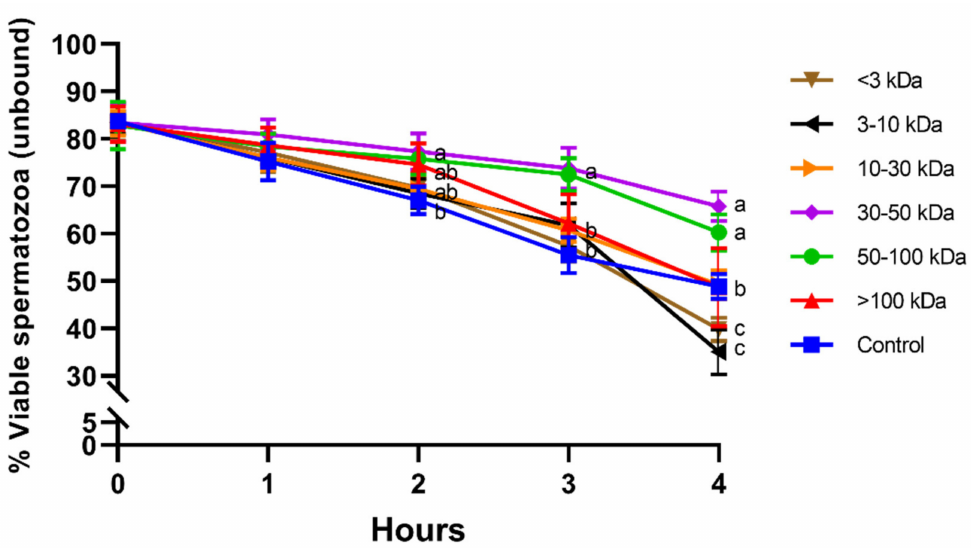
Figure 4. Percentages of viable spermatozoa in the unbound population for different seminal plasma fractions and throughout incubation at 38 ◦ C for 4 h. Different superscripts (a–c) mean significant differences between seminal plasma fractions within a given time point ( p ≤ 0.05). Data are shown as mean ± SD for 12 independent